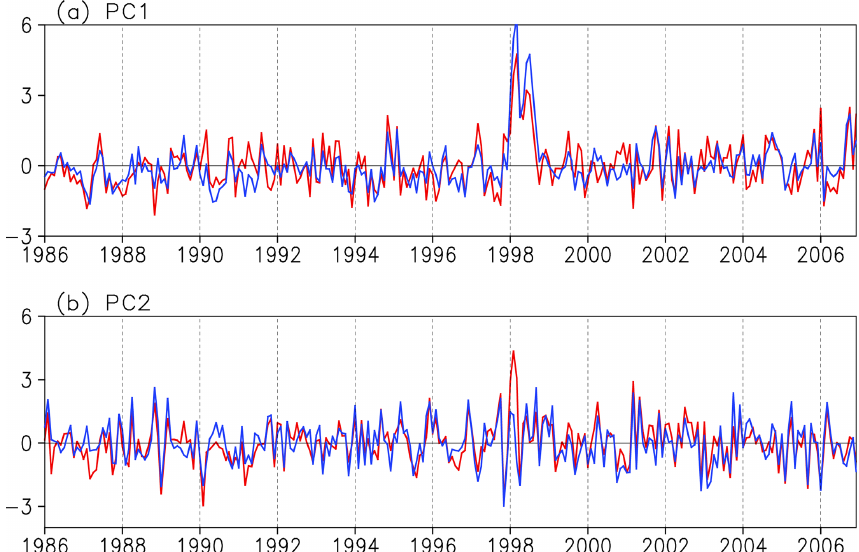
Figure 2. (a) The first principal components (PC1) of the monthly PM 2 . 5 concentrations where the red and blue lines are for the surface and column concentrations, respectively. (b) As in (a) but for